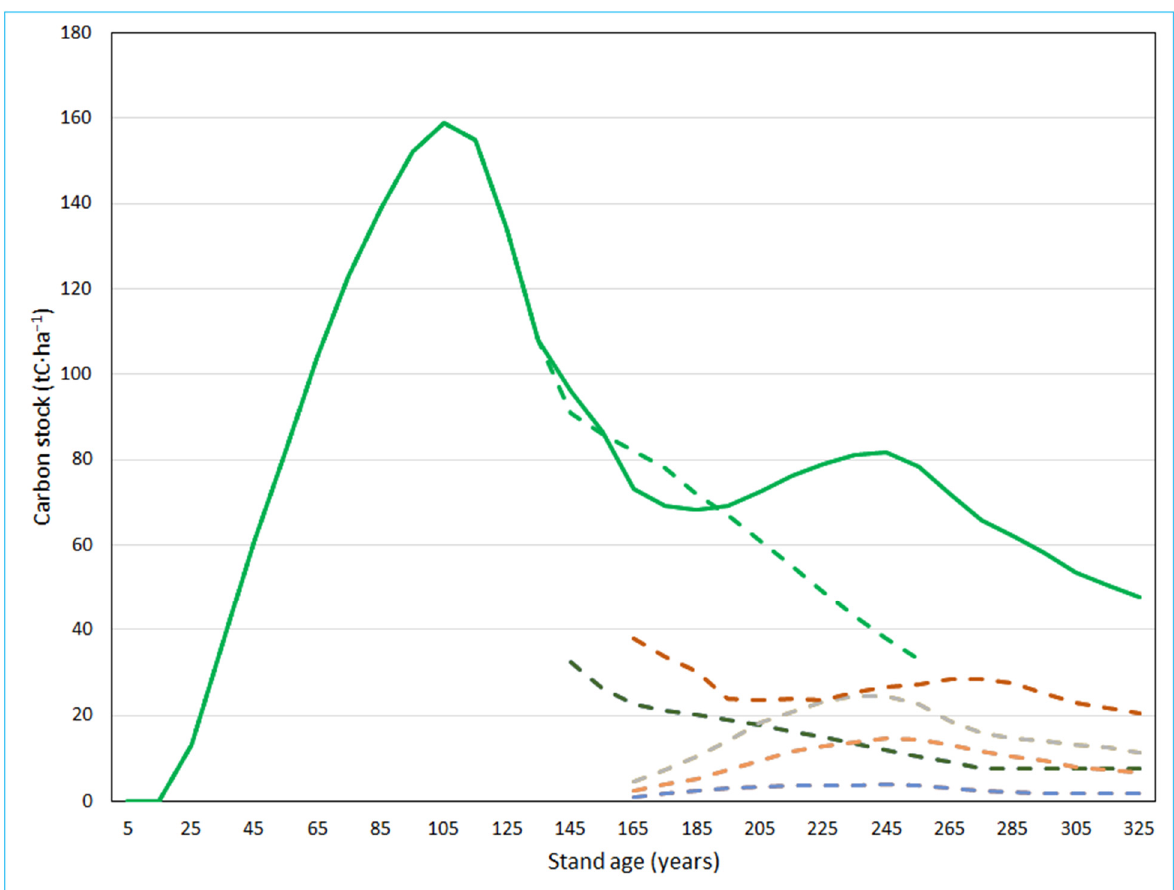
Figure 3. Composite (solid line) and pre- and post-transitional (dashed lines) yield curves for the jack pine-black spruce forest unit in the Pic River Forest management unit in northwestern Ontario. Yield curves for the original and post-transition FUs are shown using green and other colours, respectively (see Table S3 in Supplementary Materials for the list of post-transition FUs).